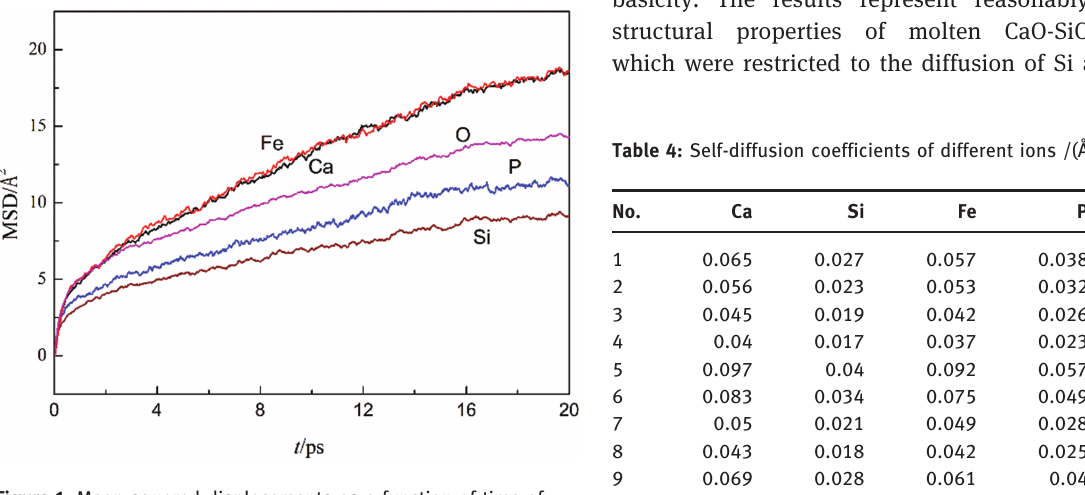
Figure 1: Mean squared displacements as a function of time of different ions in the CaO-SiO 2 -P 2 O 5 -FeO system at 1,673 K.